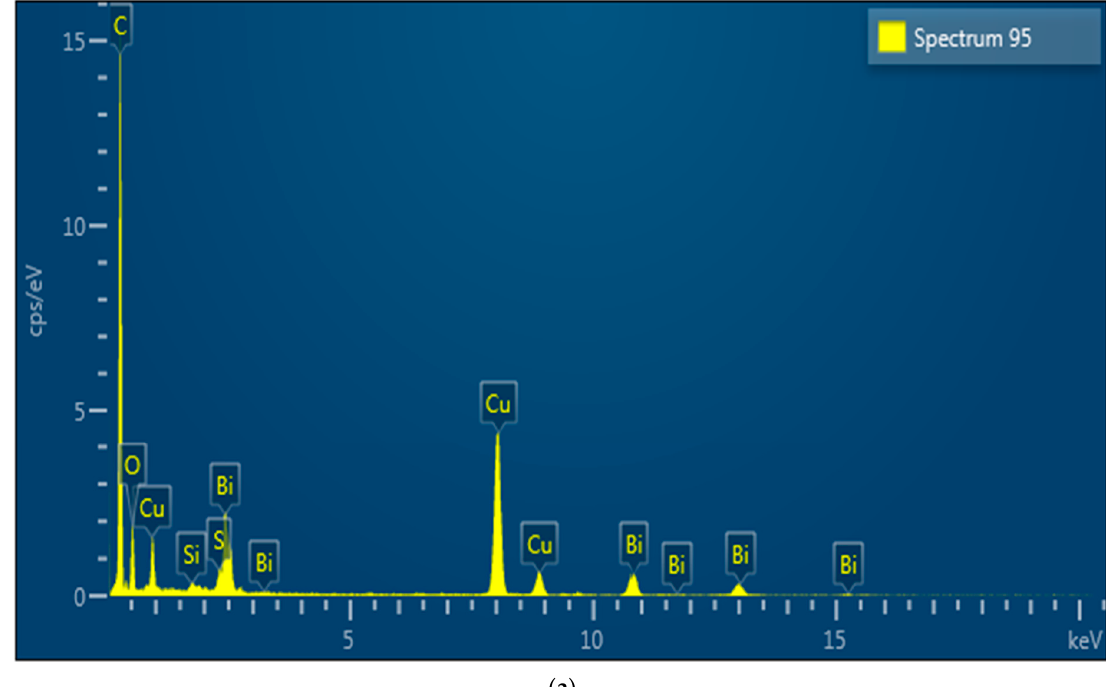
Figure 1. Transmission electron microscopy (TEM) images of the synthesized bismuth nanoparticles with image focus zoom 50 nm ( a ), 20 nm ( b ), and 5 nm ( c ). ( d ) selected area electron diffraction (SAED).